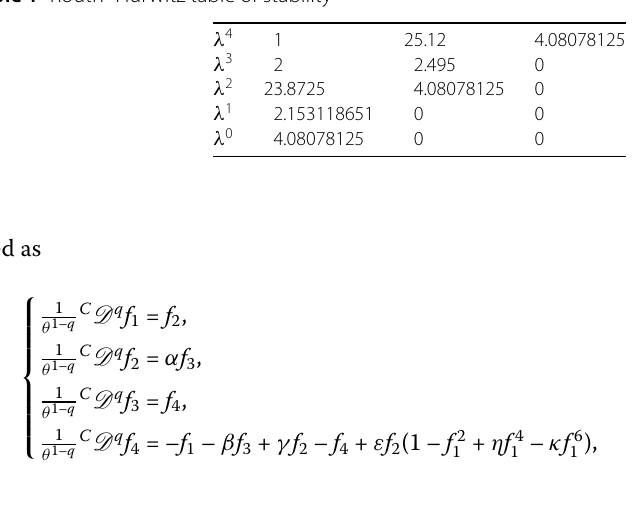
Table 1 Routh–Hurwitz table of